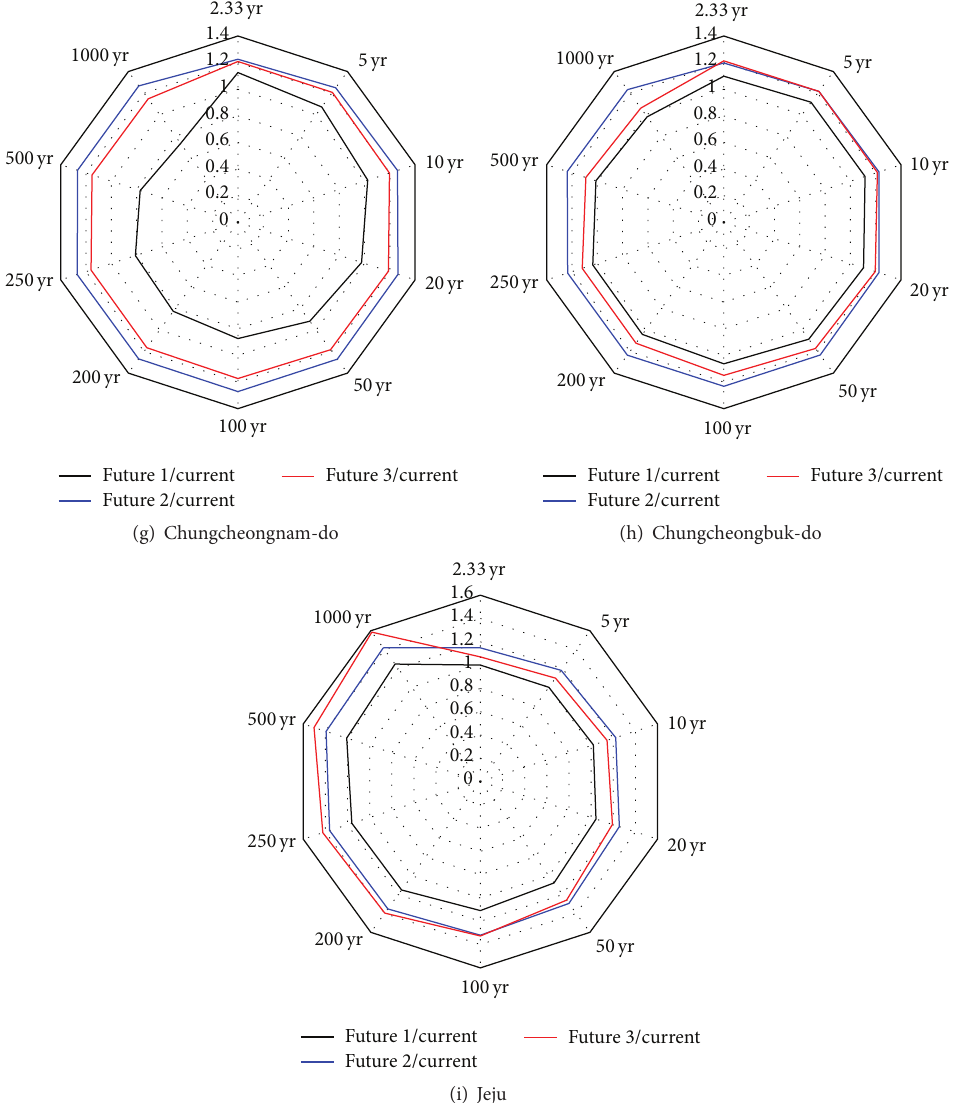
Figure 9: Ratio of drought magnitude in the future climate to the current